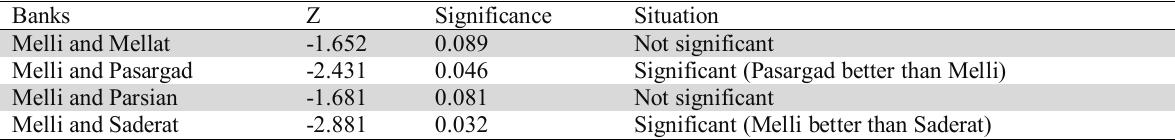
Mann-Whitney test for services